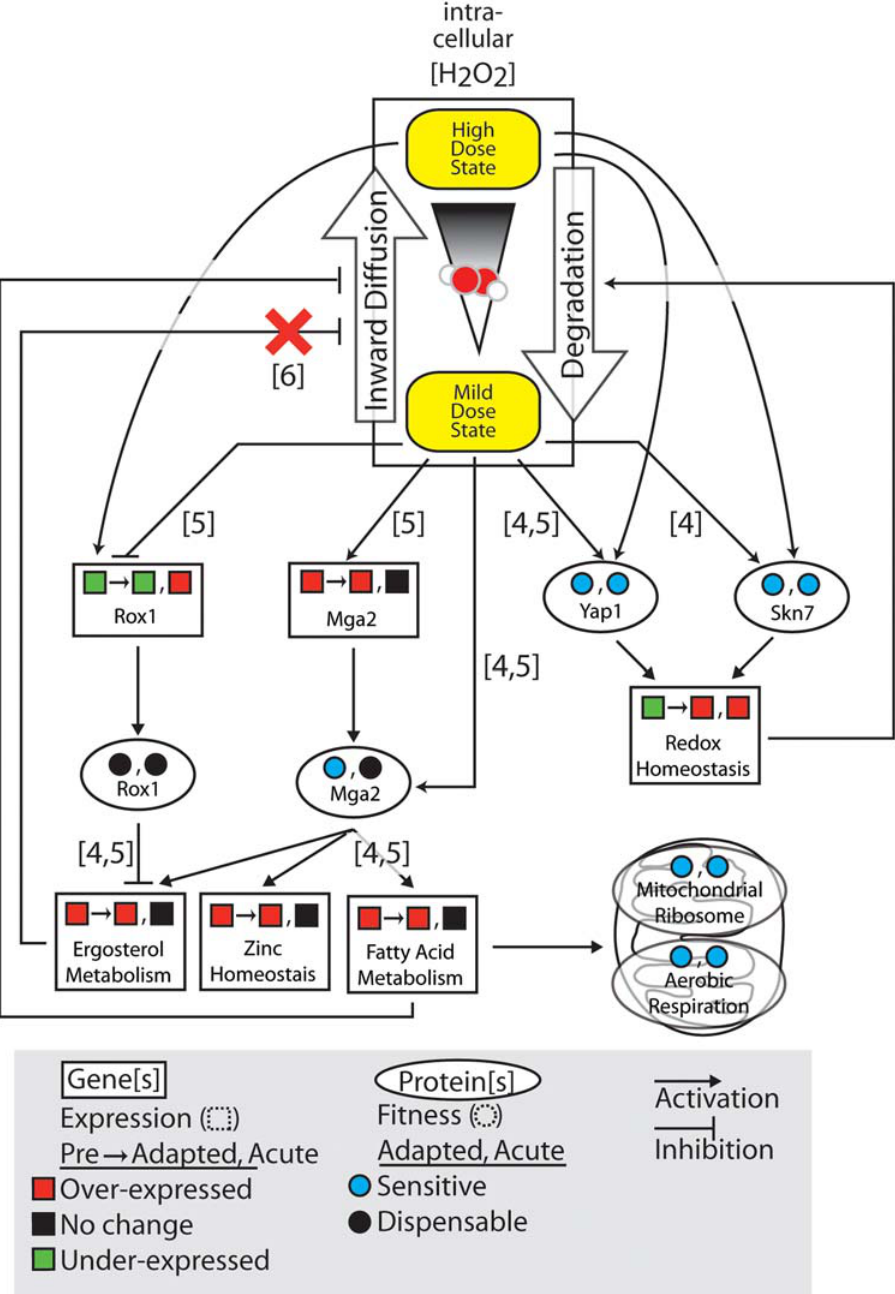
Figure 7. Summary of the adaptive response. Results and hypotheses regarding transcriptional regulators and functional categories identified in this study are summarized. The influence of hydrogen peroxide is determined by its concentration within the cell. In addition to treatment dose, several cellular processes affect the level of H 2 O 2 . In order to enter the cell, hydrogen peroxide must first diffuse across the plasma membrane. Inside the cell, peroxide levels are reduced by degradation into oxygen and water. Squares denote the expression of genes or gene sets (rectangles) following each of the three treatment protocols (pretreatment, adapted, and acute). Conversely, circles denote the sensitivity of the corresponding gene deletion for a particular protein or protein set (oval) in the adapted and acute treatment protocol. Arrows between different objects indicate either an activating (triangular arrowhead) or inhibitory (flat arrowhead) influence. The figure number(s) which provides support for each link are shown in brackets. A red ‘‘X’’ denotes a hypothesis which is refuted by experimental